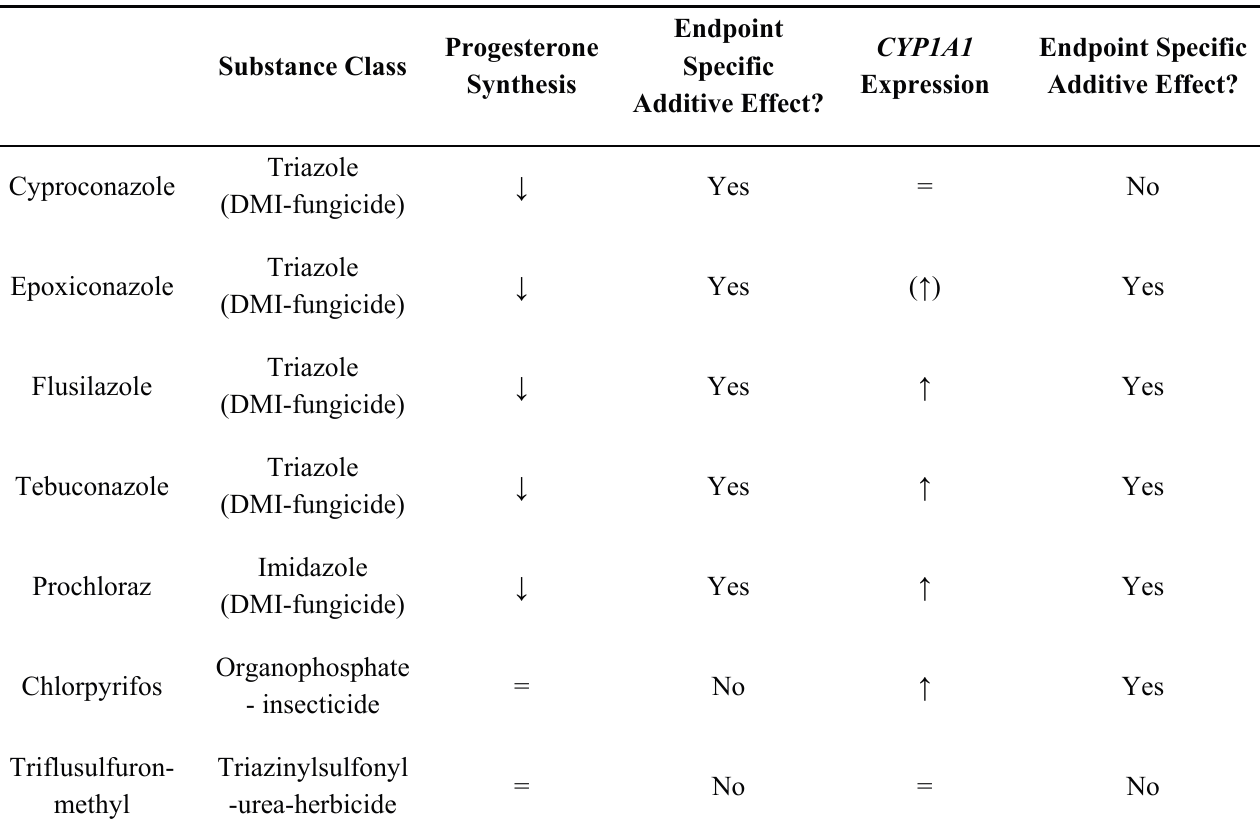
Table 2. Summary of effects on the endpoints progesterone synthesis and CYP1A1 mRNA expression. Substances affecting a similar molecular endpoint revealed additive effects for this specific endpoint. DMI: (ergosterol)demethylase inhibitor; ↓ significantly ( p < 0.05) down-regulated; ↑ significantly ( p < 0.05) up-regulated; = no changes